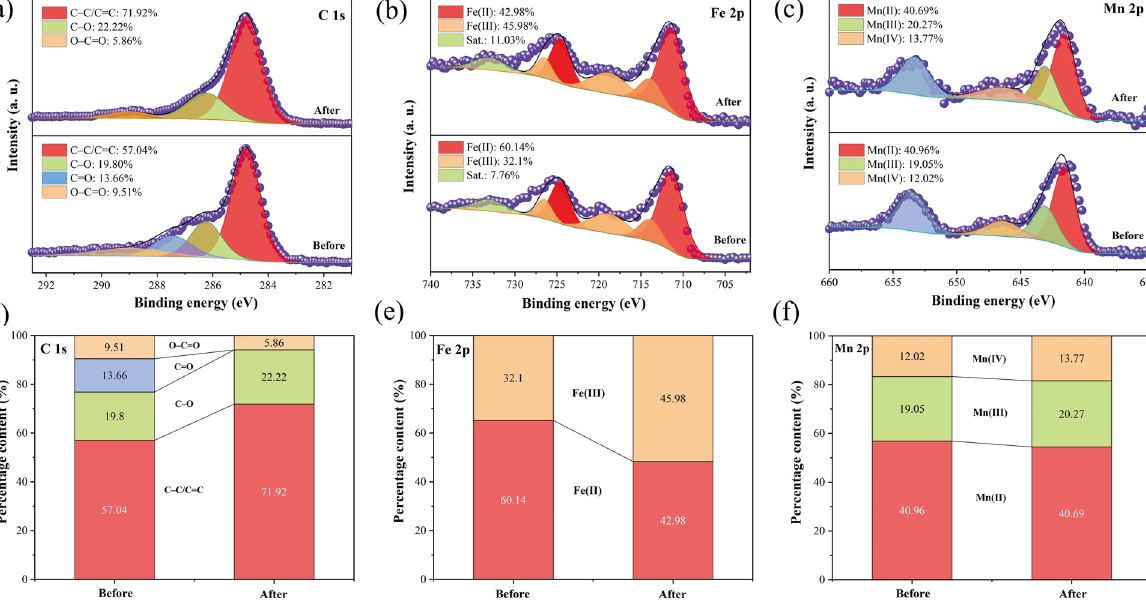
Fig. 5 XPS spectra of C 1 s ( a ), O 1 s ( b ), Fe 2p ( c ), and Mn 2p ( d ) before and after reaction, Percentage contents of C 1s ( e ), O 1s ( f ), Fe 2p ( g ), and Mn 2p ( h